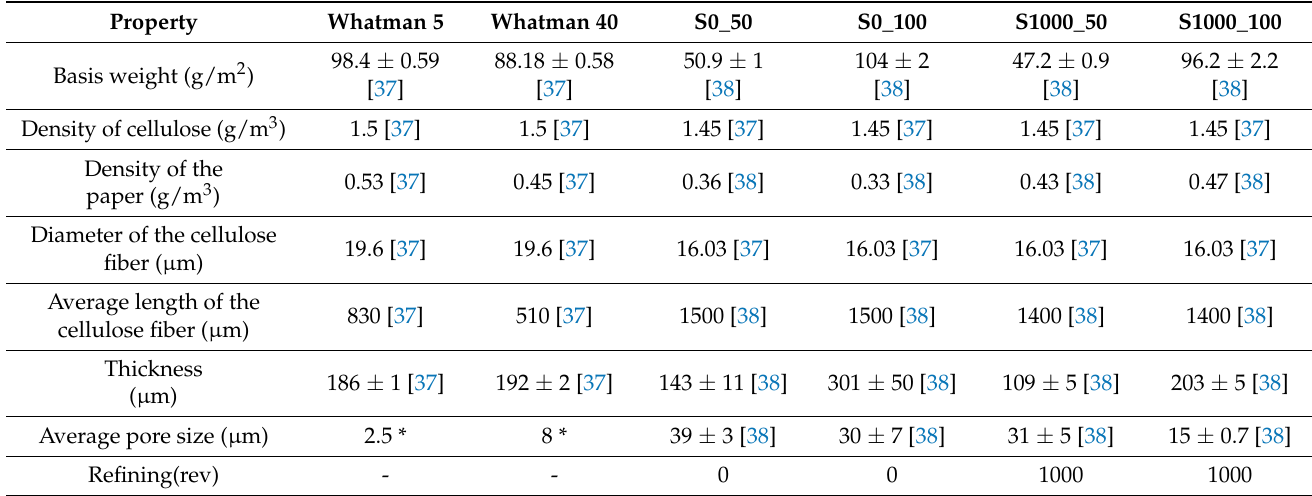
Table 2. Paper substrate and cellulose fiber